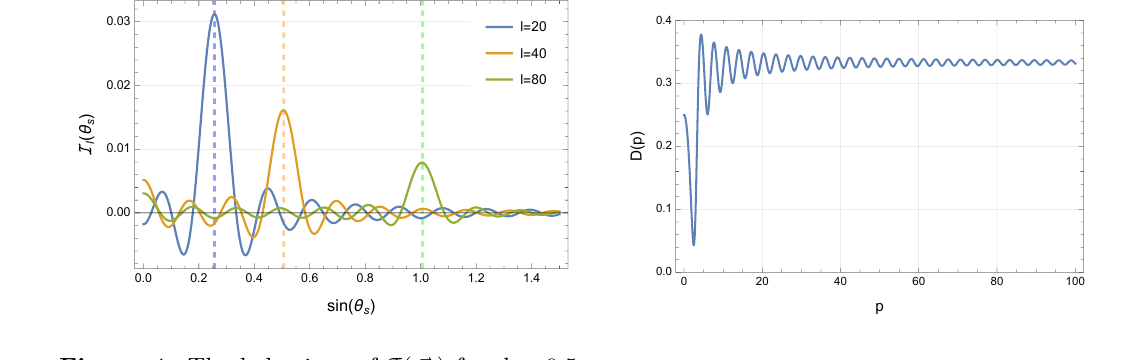
Figure 5 . The behavior of D( p )